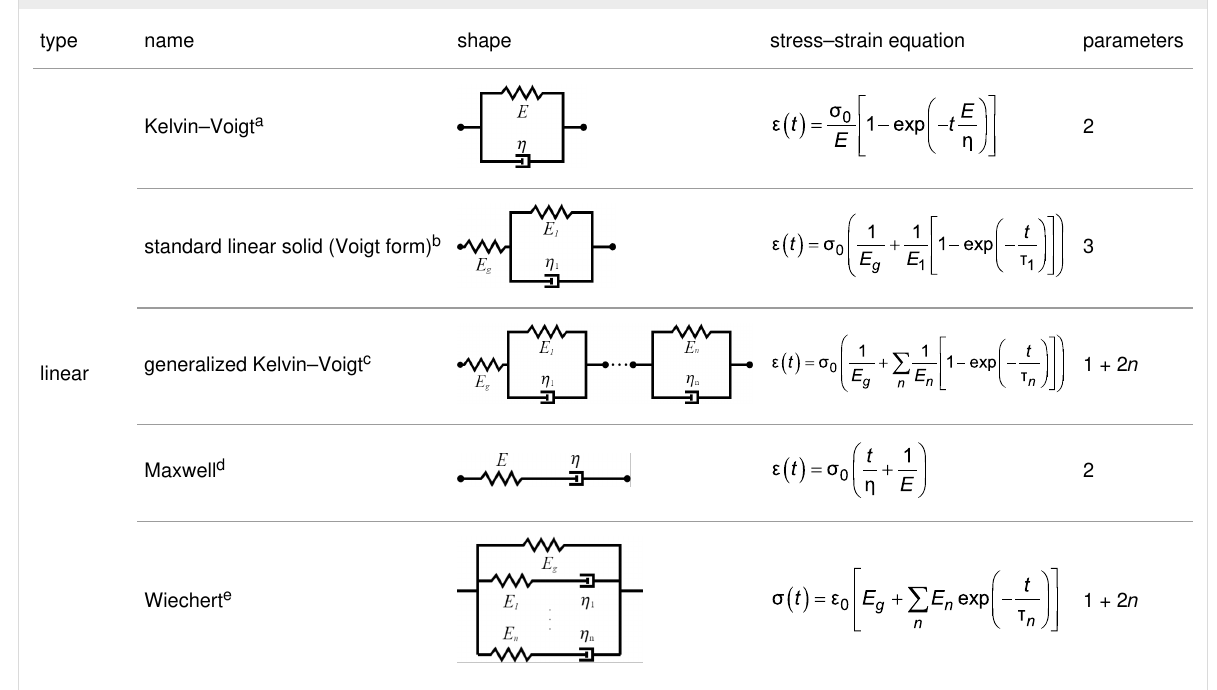
Table 1: Summary of viscoelastic models and the corresponding applications